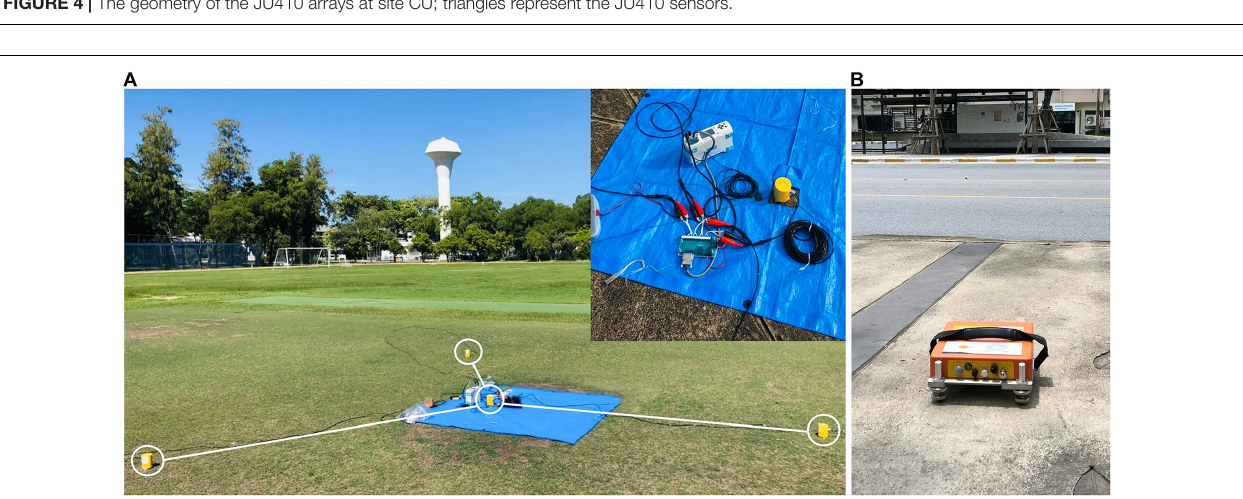
FIGURE 5 | (A) Velocity-meter (Data logger HKS-9700 with HS-1 sensor) being used for small aperture array measurement in Bangkok (B) Datamark JU410 recording data at site MU.